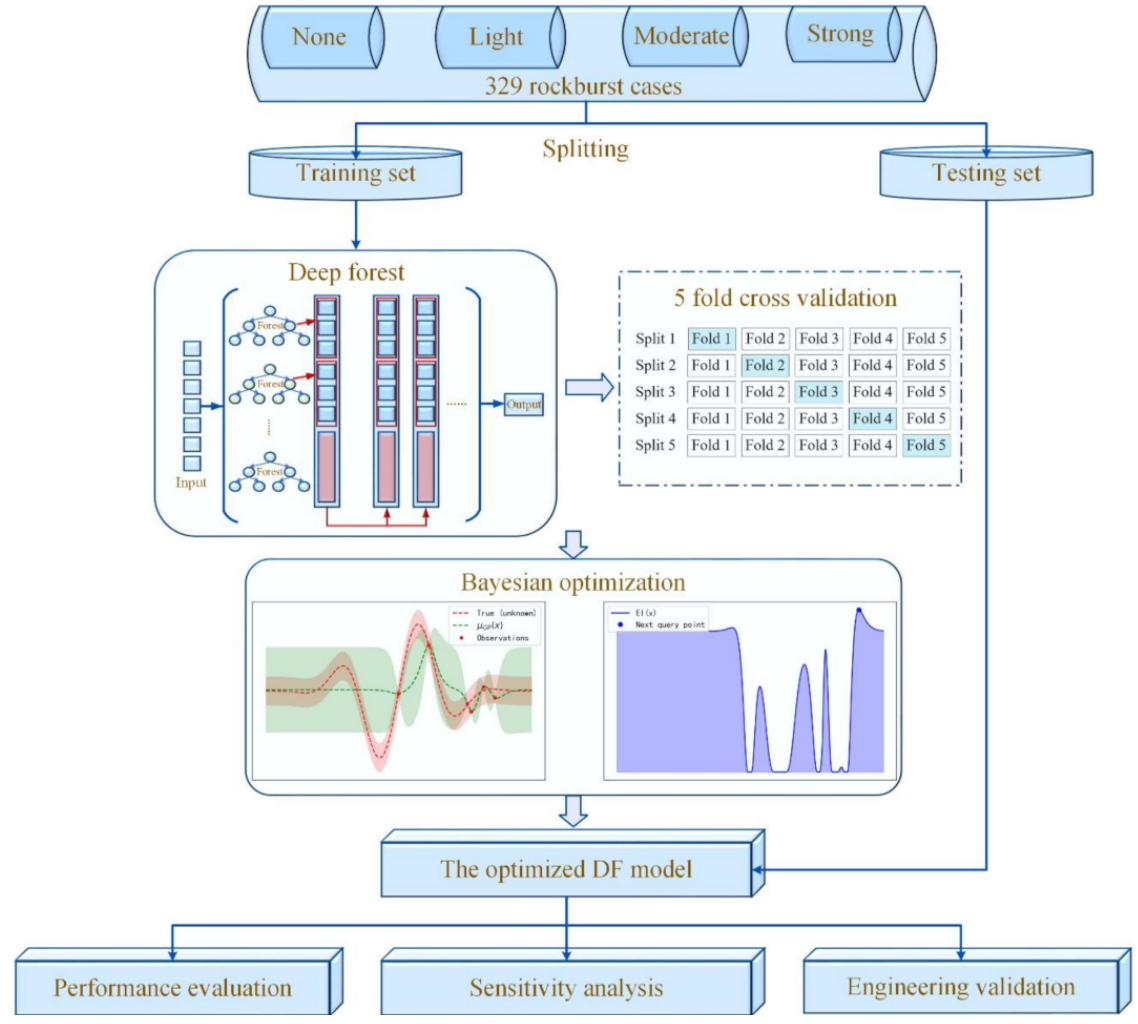
Figure 5. The flowchart to develop DF model for rockburst